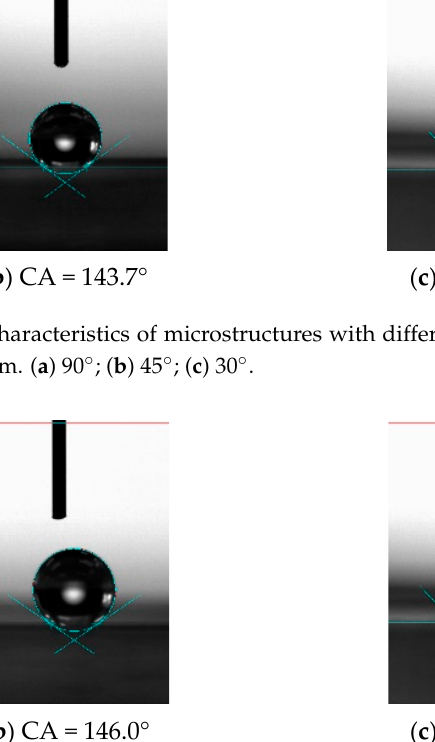
Figure 17. Hydrophobic characteristics of microstructures with different tilt angles when the mi- crostructure width is 60 μ m. ( a ) 90°; ( b ) 45°; ( c ) 30°.